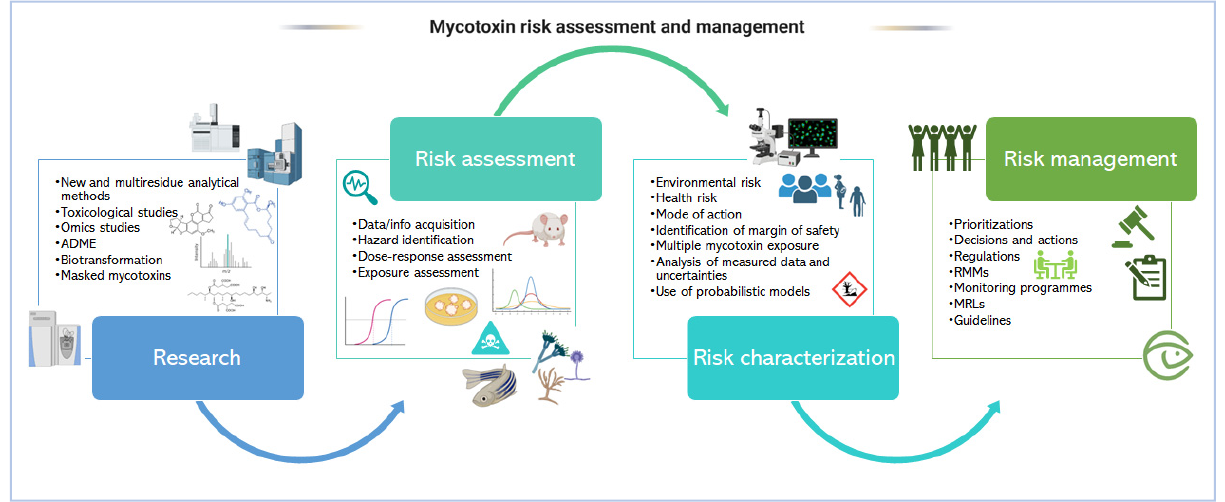
Figure 1. Risk assessment and management of mycotoxins in seafood: the possible development framework of the new regulation.